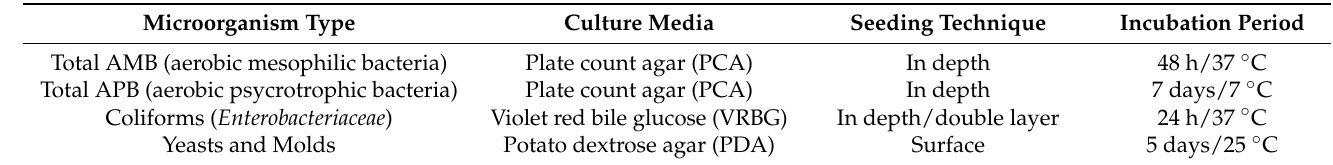
Table 1. Culture media, seeding techniques, and conditions of incubation used in microbiologi- cal